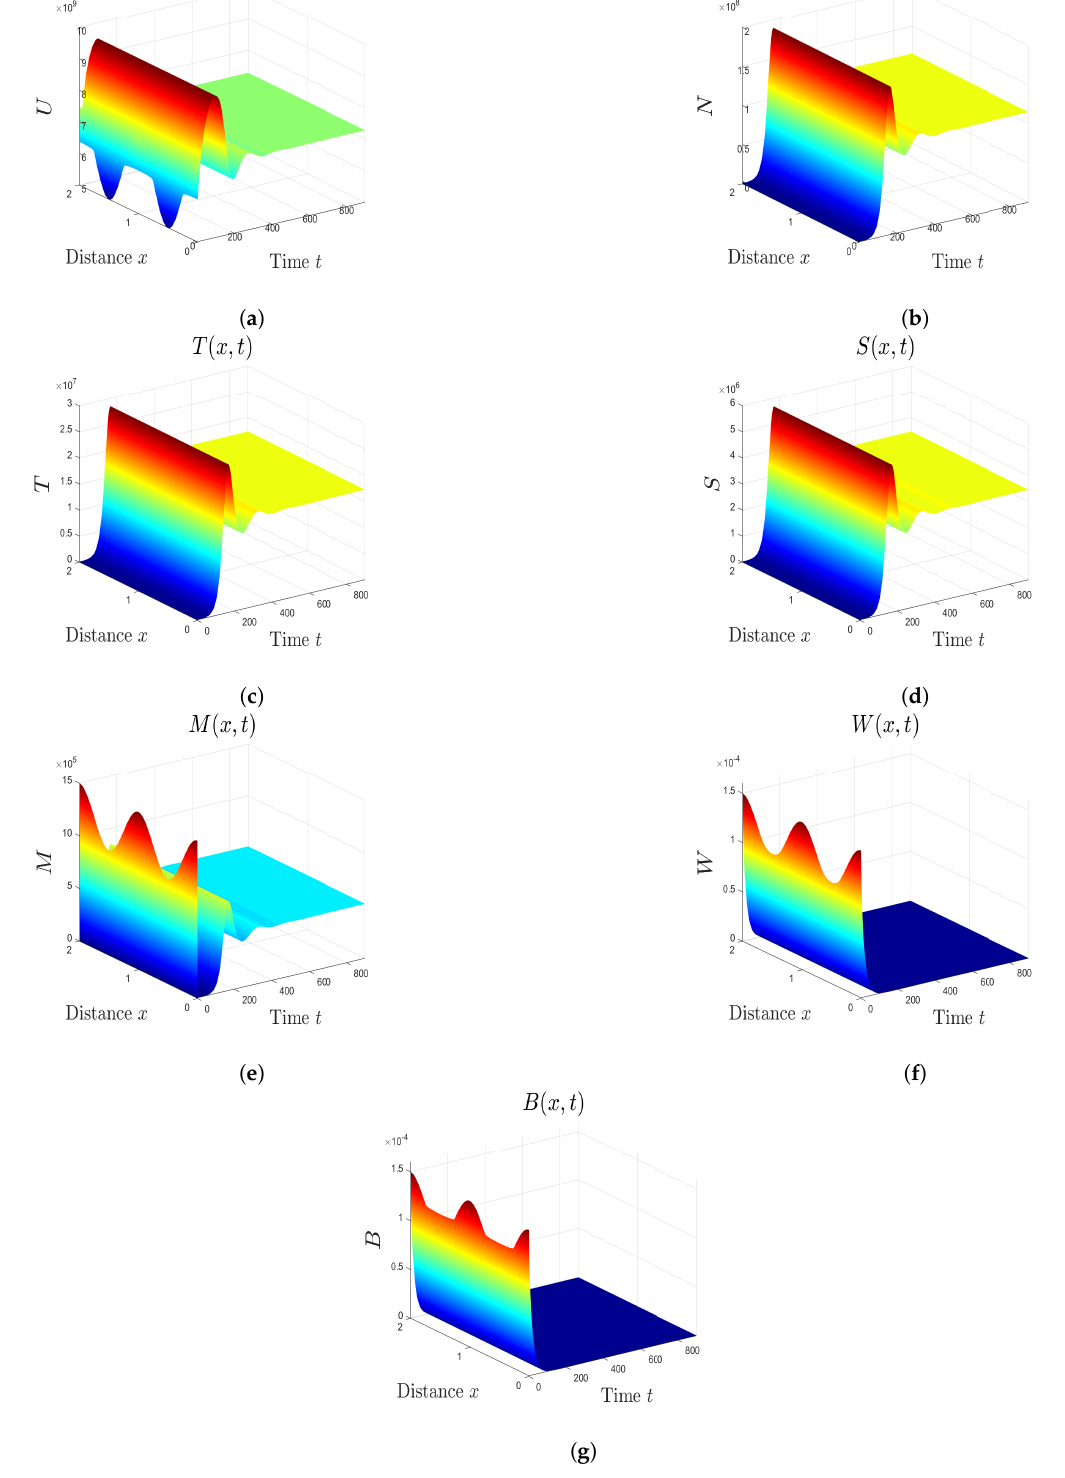
Figure 2. The numerical simulations of model (3) when R i > 1, R j ≤ 1, and R k ≤ 1. The immune-free equilibrium E 1 is globally asymptotically stable. The subfigures show the spatiotemporal behaviors of ( a ) uninfected red blood cells U , ( b ) ring infected red blood cells N , ( c ) trophozoite infected red blood cells T , ( d ) schizont infected red blood cells S , ( e ) free merozoites M , ( f ) CTLs W , and ( g ) antibodies B